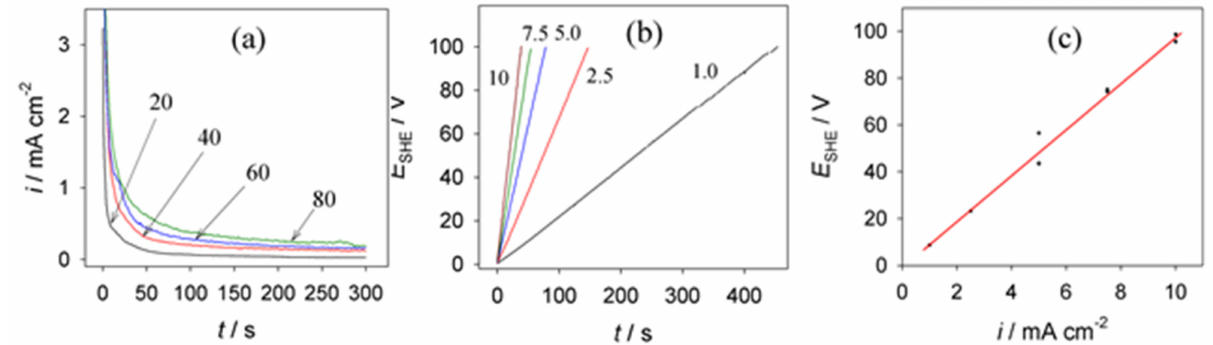
Figure 1. Variations in current transience ( a ) and Al anodizing voltage ( b ) with processing time at the indicated voltage ( a ) and current density ( b ) values in 0.2 mol · L − 1 NaVO 3 , pH 7.1. ( c ) Typical voltage–current plot for 0.2 mol · L − 1 NaVO 3 slightly alkaline (pH 8.4)